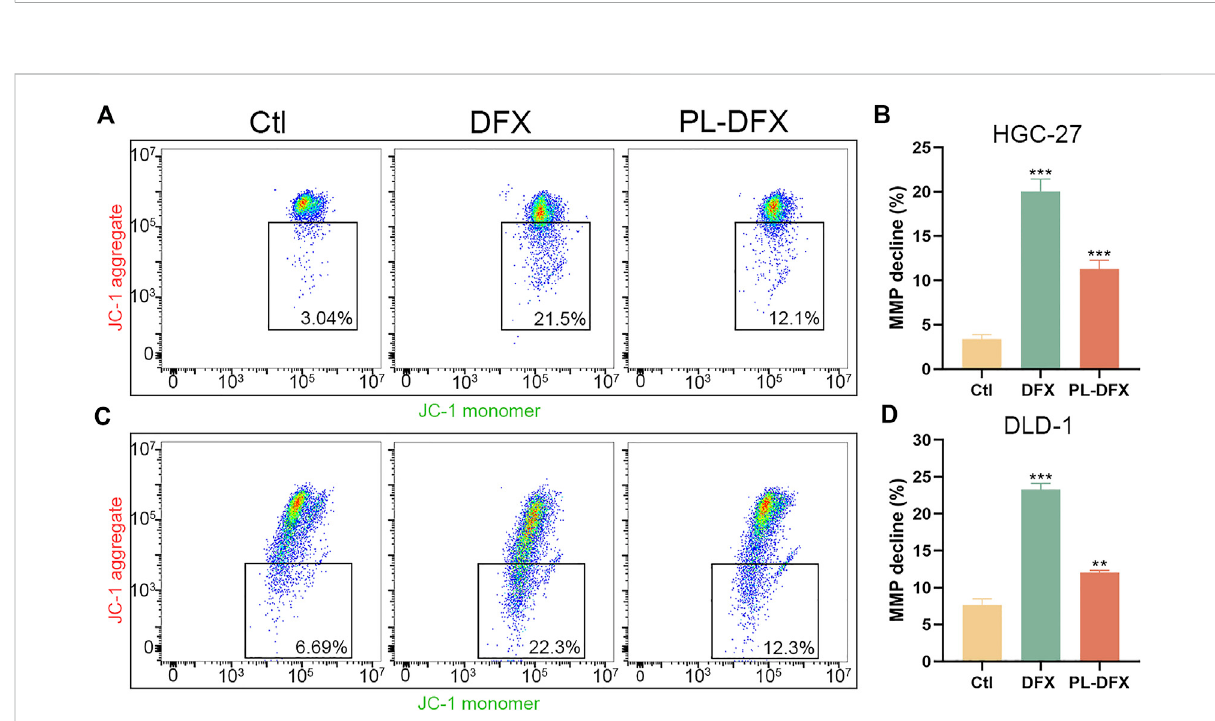
FIGURE 8 Impact of DFX and PL-DFX on mitochondria membrane potential. (A,B) Mitochondria membrane potential detected by JC-1 in HGC-27 cells incubated with DFX (50 μ M) and PL-DFX (25 μ M) for 24 h (C,D) Mitochondria membrane potential detected by JC-1 in DLD-1 cells incubated with DFX (50 μ M) and PL-DFX (25 μ M) for 24